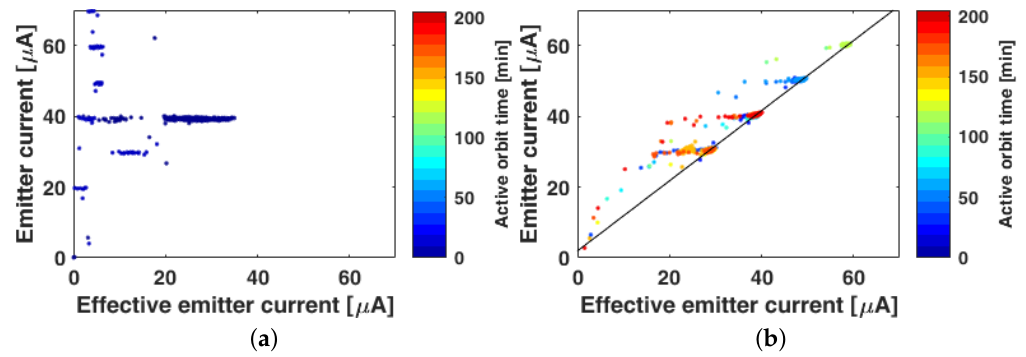
Figure 13. Effective emitter current vs. emitter current of thruster B. ( a ) Early operations with unstable behavior. ( b ) After commissioning the effective emitter current stabilized. A black linear trend line following Equation (14) is under the data.